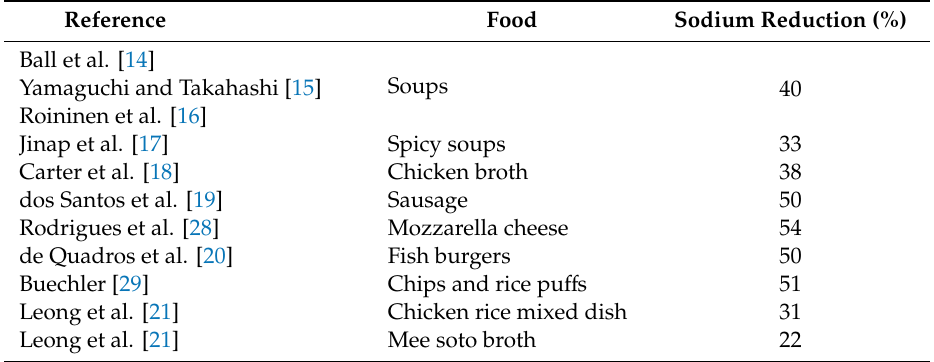
Table 1. Sodium reduction in various food products with the incorporation of glutamates.